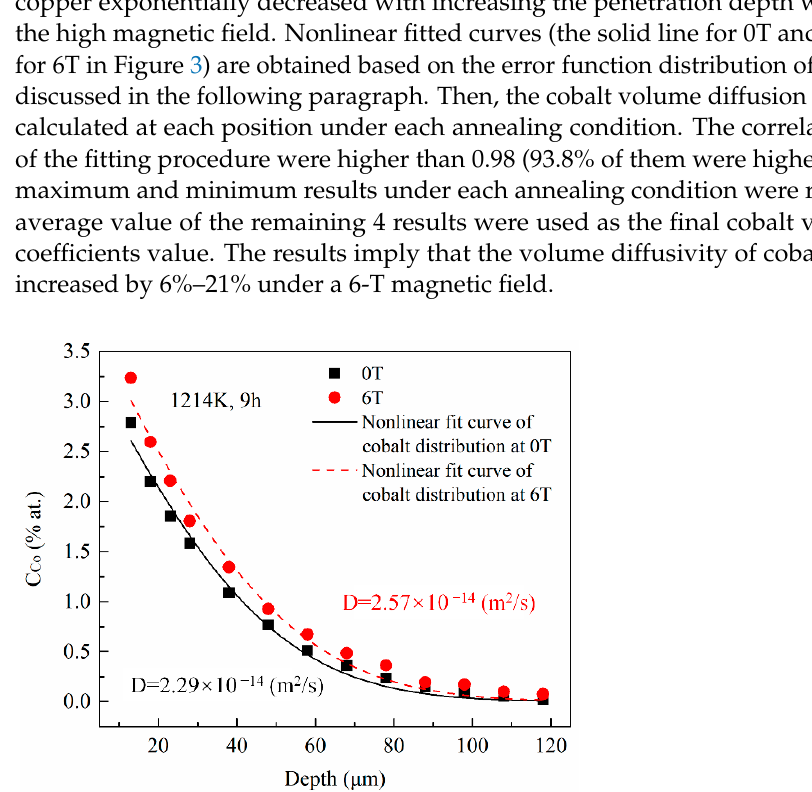
Figure 3. The cobalt concentration profiles in copper annealed at 1214 K with and without the high magnetic field. The diffusivities of cobalt in copper were estimated using the nonlinear curve fitting based on the error function (the solid and the dashed lines). The angle between the magnetic field direction and the cobalt diffusion direction is 180°.